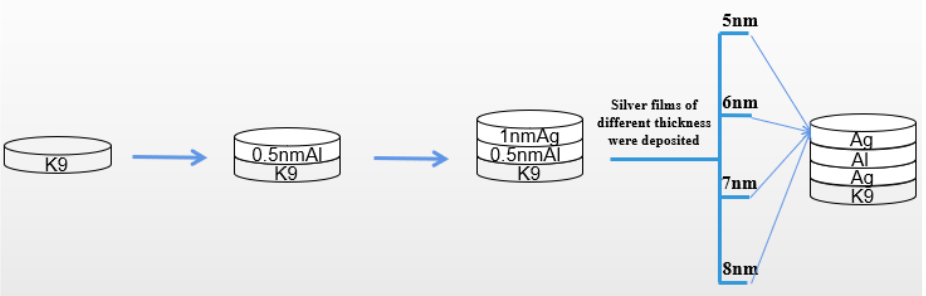
Figure 8. Depiction of three different structures of silver films.